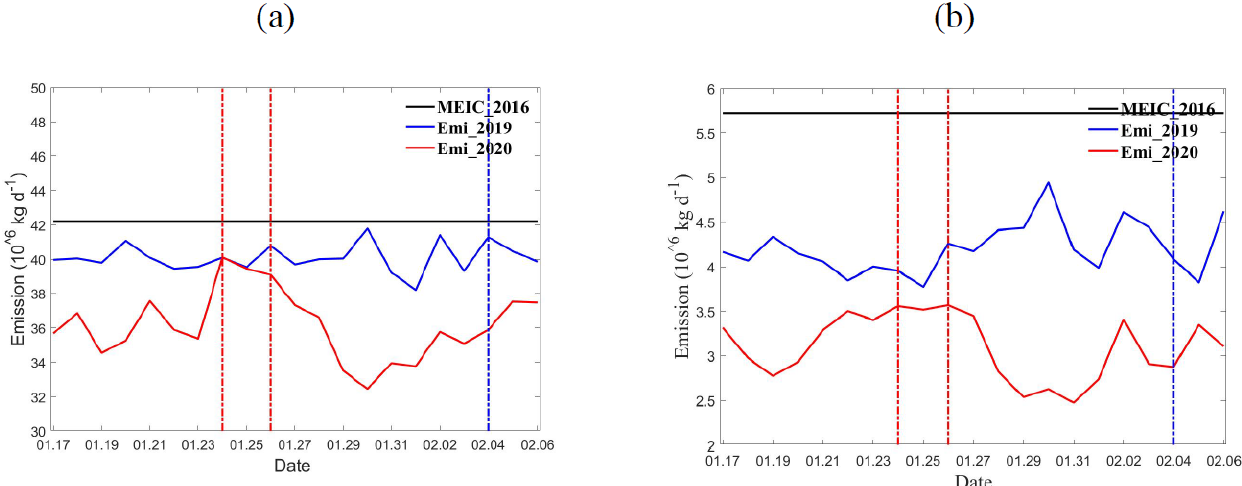
Figure 10. Time series of daily SO 2 emissions in (a) China and (b) central China. The red dotted lines represent the dates of the start of national lockdown and the Chinese Spring Festival in 2020. The blue dotted line represents the Chinese Spring Festival in 2019. Units: 10 6 kgd − 1